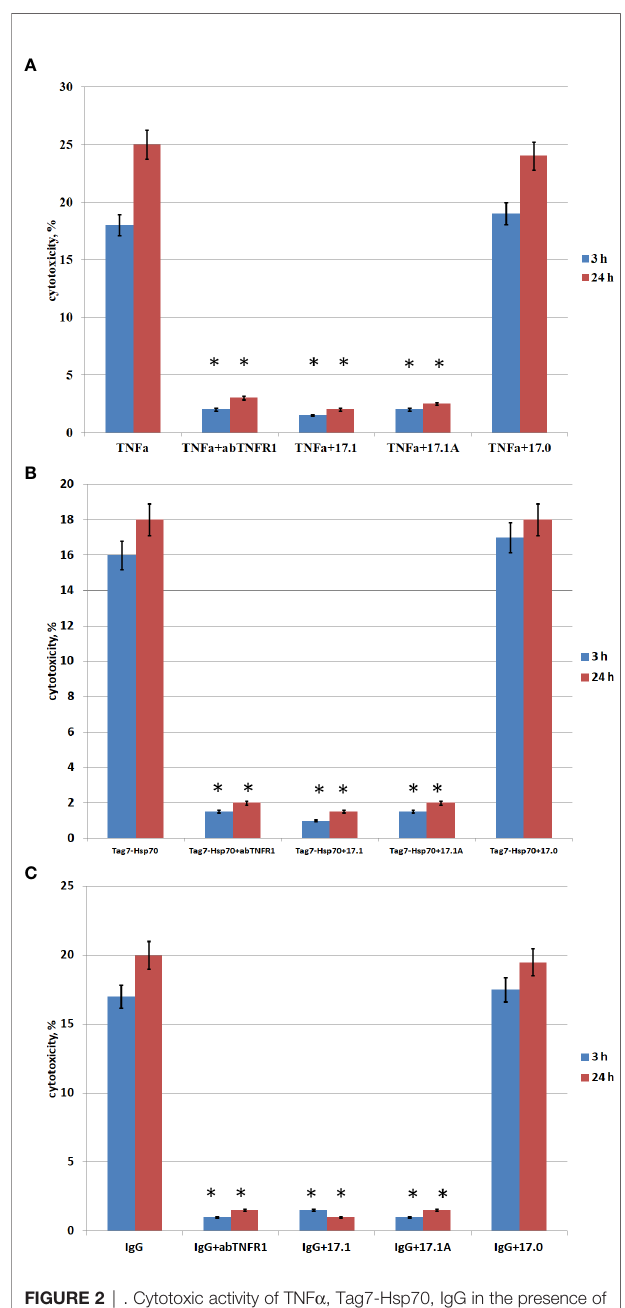
FIGURE 2 | . Cytotoxic activity of TNF a , Tag7-Hsp70, IgG in the presence of inhibitory peptides. Inhibitory 17.1, 17.1 А , 17.0 peptides were added at a concentration 10 − 9 M 1 h prior to incubation with the cytotoxic agent TNF a 10 − 10 M (A) , Tag7-Hsp70 10 − 9 M (B) , IgG 10 − 10 M (C) . Anti-TNFR1 antibodies (1: 100) were added to the cells also 1 h prior to incubation with the cytotoxic agents (control). The cytotoxic activity was measured 3 and 24 h after incubation of cells with the cytotoxic agent using trypan blue staining. All data are presented as mean ± SEM for at least three independent replicates. (*p<0.05 t-test vs